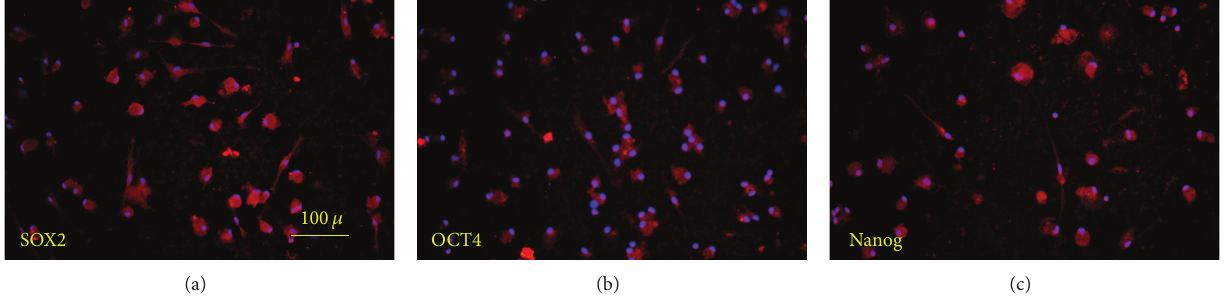
Figure 2: The immunofluorescence of the cells showed that a subpopulation of the breast milk-derived cells reacted for OCT4, Nanog, and SOX2 antibodies.